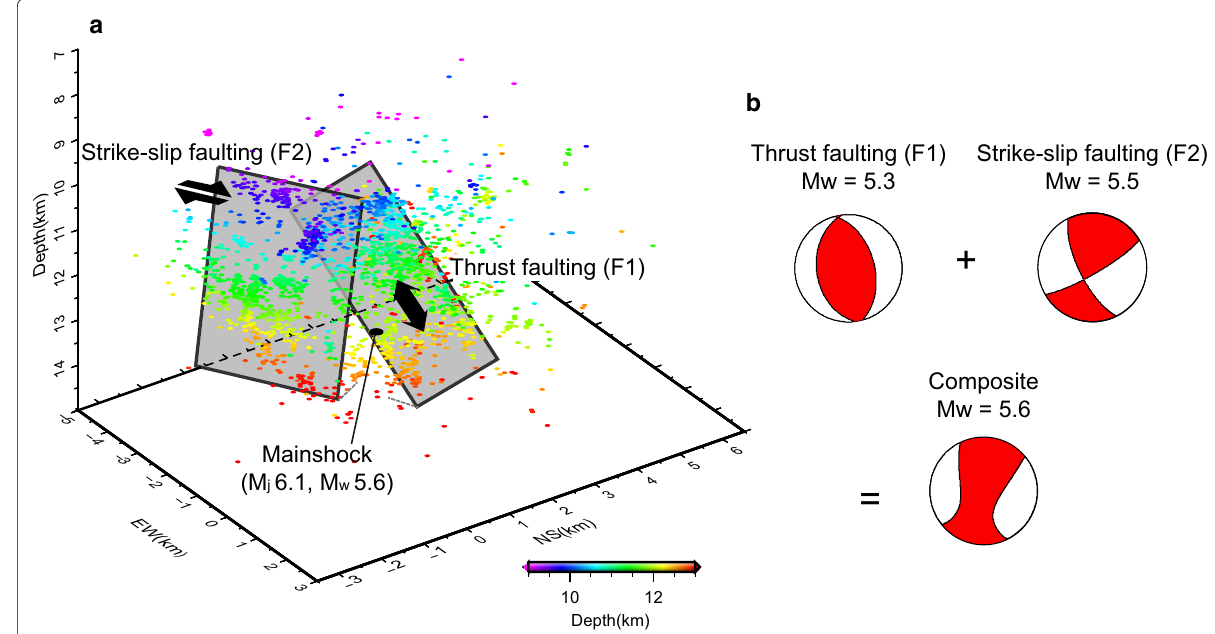
Fig. 4 Source fault model of the mainshock rupture. a Perspective view of the relocated aftershocks (colored to depth) and the inferred fault orientations. The two gray rectangles represent the NNW–SSE-striking thrust dipping to the east (F1) and the sub-vertical, ENE–WSW-striking strike-slip fault (F2). b The best combination of two double-couple moment tensors found for the F1 and F2 faults to explain the observed mainshock CMT solution (F1: